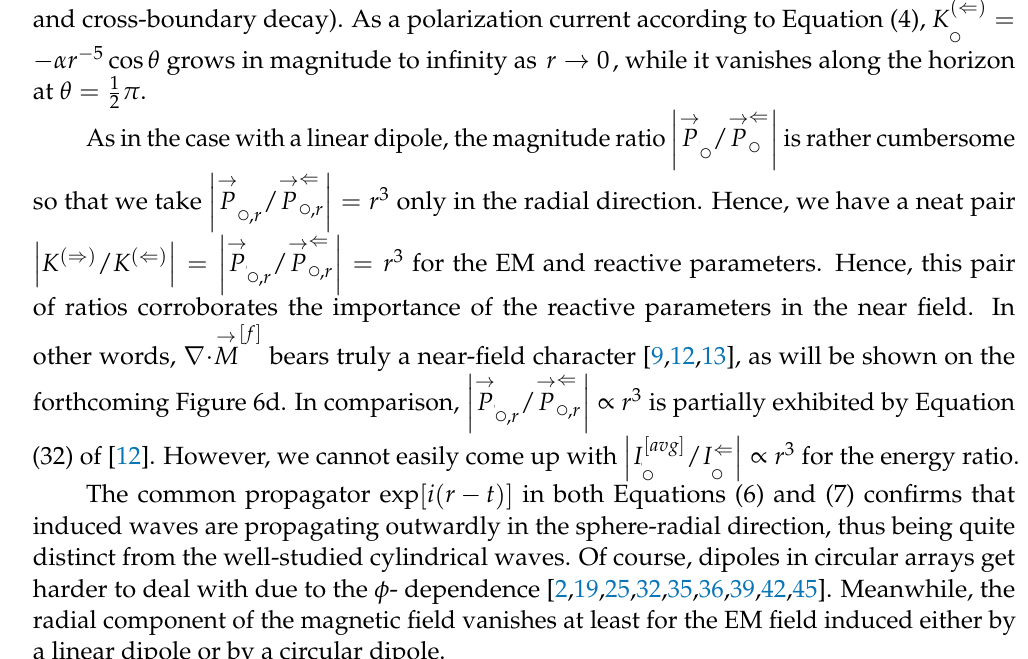
  Figure 1. ( a ) Decomposition of a Poynting vector P into an orbital energy flux O and a spin   energy flux S . Besides, M is a spin angular momentum (SAM) density. ( b ) The coordinate systems. On the origin lies a primary electric point dipole represented by its unit vector ˆ p . ( c ) A     linear dipole ˆ p with its dipole axis lying parallel to the vertical axis leads to a pencil-hull-like Figure 1. ( a ) Decomposition of a Poynting vector P into an orbital energy flux O and a spin  Figure 1. ( a ) Decomposition of a Poynting vector P into an orbital energy flux O and a spin     tapered cylindrical surface designating higher values for the degree of circular polarization (DoCP). energy flux S . Besides, M is a spin angular momentum (SAM) density. ( b ) The coordinate  energy flux S . Besides, M is a spin angular momentum (SAM) density. ( b ) The coordinate    with its dipole axis lying on the horizontal plane leads to a filled solid ( d ) A circular dipole ˆ p Figure 1. ( a ) Decomposition of a Poynting vector P into an orbital energy flux O and a spin systems. On the origin lies a primary electric point dipole represented by its unit vector ˆ p . ( c ) A Figure 1. ( a ) Decomposition of a Poynting vector P into an orbital energy flux O and a spin  systems. On the origin lies a primary electric point dipole represented by its unit vector ˆ p . ( c ) A     energy flux S . Besides, M is a spin angular momentum (SAM) density. ( b ) The coordinate ○ cone of higher values of DoCP.  energy flux S . Besides, M is a spin angular momentum (SAM) density. ( b ) The coordinate linear dipole ˆ p with its dipole axis lying parallel to the vertical axis leads to a pencil-hull-like   linear dipole ˆ p with its dipole axis lying parallel to the vertical axis leads to a pencil-hull-like     Figure 1. ( a ) Decomposition of a Poynting vector P into an orbital energy flux O and a spin systems. On the origin lies a primary electric point dipole represented by its unit vector ˆ p . ( c ) A Figure 1. ( a ) Decomposition of a Poynting vector P into an orbital energy flux O and a spin systems. On the origin lies a primary electric point dipole represented by its unit vector ˆ p . ( c ) A   tapered cylindrical surface designating higher values for the degree of circular polarization (DoCP).   tapered cylindrical surface designating higher values for the degree of circular polarization (DoCP). energy flux S . Besides, M is a spin angular momentum (SAM) density. ( b ) The coordinate energy flux S . Besides, M is a spin angular momentum (SAM) density. ( b ) The coordinate linear dipole ˆ p with its dipole axis lying parallel to the vertical axis leads to a pencil-hull-like with its dipole axis lying on the horizontal plane leads to a filled solid ( d ) A circular dipole ˆ p linear dipole ˆ p with its dipole axis lying parallel to the vertical axis leads to a pencil-hull-like  with its dipole axis lying on the horizontal plane leads to a filled solid ( d ) A circular dipole ˆ p    systems. On the origin lies a primary electric point dipole represented by its unit vector ˆ p . ( c ) A systems. On the origin lies a primary electric point dipole represented by its unit vector ˆ p . ( c ) A tapered cylindrical surface designating higher values for the degree of circular polarization (DoCP). ○ tapered cylindrical surface designating higher values for the degree of circular polarization (DoCP). cone of higher values of DoCP. ○ cone of higher values of DoCP.   linear dipole ˆ p with its dipole axis lying parallel to the vertical axis leads to a pencil-hull-like with its dipole axis lying on the horizontal plane leads to a filled solid ( d ) A circular dipole ˆ p linear dipole ˆ p with its dipole axis lying parallel to the vertical axis leads to a pencil-hull-like  with its dipole axis lying on the horizontal plane leads to a filled solid ( d ) A circular dipole ˆ p        Figure 1. ( a ) Decomposition of a Poynting vector P into an orbital energy flux O and a spin tapered cylindrical surface designating higher values for the degree of circular polarization (DoCP). Figure 1. ( a ) Decomposition of a Poynting vector P into an orbital energy flux O and a spin ○ tapered cylindrical surface designating higher values for the degree of circular polarization (DoCP). cone of higher values of DoCP.  ○  cone of higher values of DoCP.     with its dipole axis lying on the horizontal plane leads to a filled solid ( d ) A circular dipole ˆ p energy flux S . Besides, M is a spin angular momentum (SAM) density. ( b ) The coordinate with its dipole axis lying on the horizontal plane leads to a filled solid ( d ) A circular dipole ˆ p energy flux S . Besides, M is a spin angular momentum (SAM) density. ( b ) The coordinate       Figure 1. ( a ) Decomposition of a Poynting vector P into an orbital energy flux O and a spin Figure 1. ( a ) Decomposition of a Poynting vector P into an orbital energy flux O and a spin systems. On the origin lies a primary electric point dipole represented by its unit vector ˆ p . ( c ) A ○ cone of higher values of DoCP. systems. On the origin lies a primary electric point dipole represented by its unit vector ˆ p . ( c ) A ○   cone of higher values of DoCP.     energy flux S . Besides, M is a spin angular momentum (SAM) density. ( b ) The coordinate energy flux S . Besides, M is a spin angular momentum (SAM) density. ( b ) The coordinate linear dipole ˆ p with its dipole axis lying parallel to the vertical axis leads to a pencil-hull-like linear dipole ˆ p with its dipole axis lying parallel to the vertical axis leads to a pencil-hull-like   systems. On the origin lies a primary electric point dipole represented by its unit vector ˆ p . ( c ) A systems. On the origin lies a primary electric point dipole represented by its unit vector ˆ p . ( c ) A tapered cylindrical surface designating higher values for the degree of circular polarization (DoCP). tapered cylindrical surface designating higher values for the degree of circular polarization (DoCP). linear dipole ˆ p with its dipole axis lying parallel to the vertical axis leads to a pencil-hull-like linear dipole ˆ p with its dipole axis lying parallel to the vertical axis leads to a pencil-hull-like with its dipole axis lying on the horizontal plane leads to a filled solid ( d ) A circular dipole ˆ p    tapered cylindrical surface designating higher values for the degree of circular polarization (DoCP). tapered cylindrical surface designating higher values for the degree of circular polarization (DoCP). ○ cone of higher values of DoCP. ○ cone of higher values of DoCP.   with its dipole axis lying on the horizontal plane leads to a filled solid ( d ) A circular dipole ˆ p with its dipole axis lying on the horizontal plane leads to a filled solid ( d ) A circular dipole ˆ p   ○ ○ cone of higher values of DoCP. cone of higher values of DoCP.  